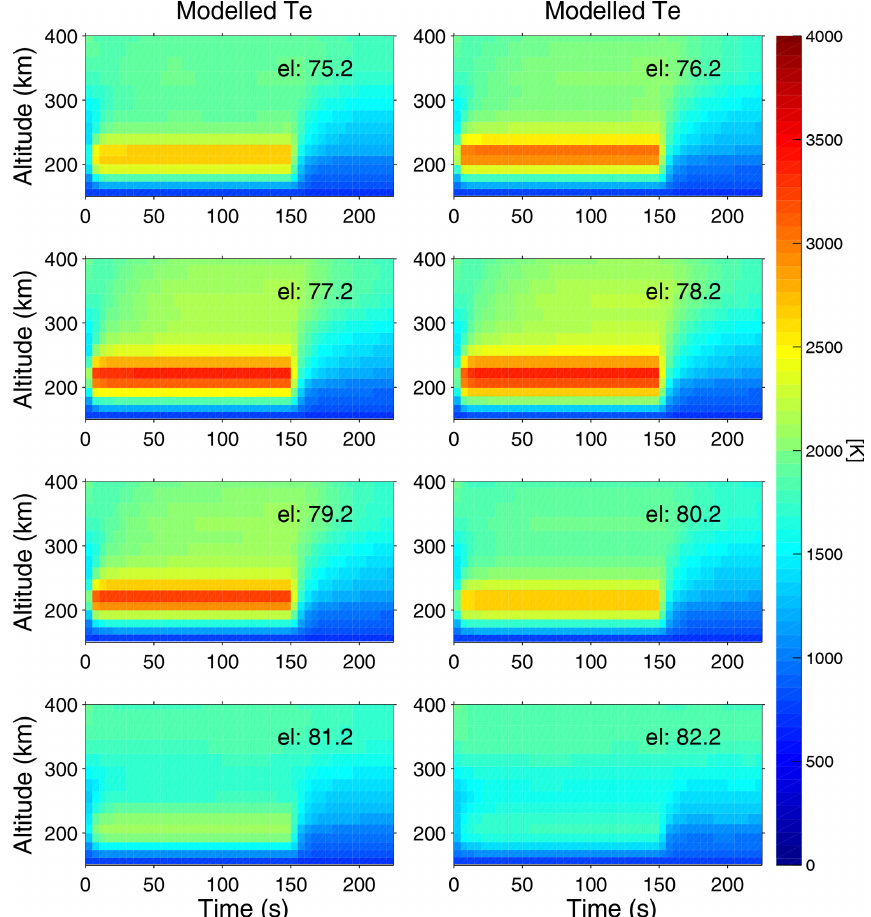
Figure 4. Modelled temporal evolution of the altitude profile of the electron temperature T e (z,t) for the different elevation angles in the experiments on 25 November 2014 (Fig.